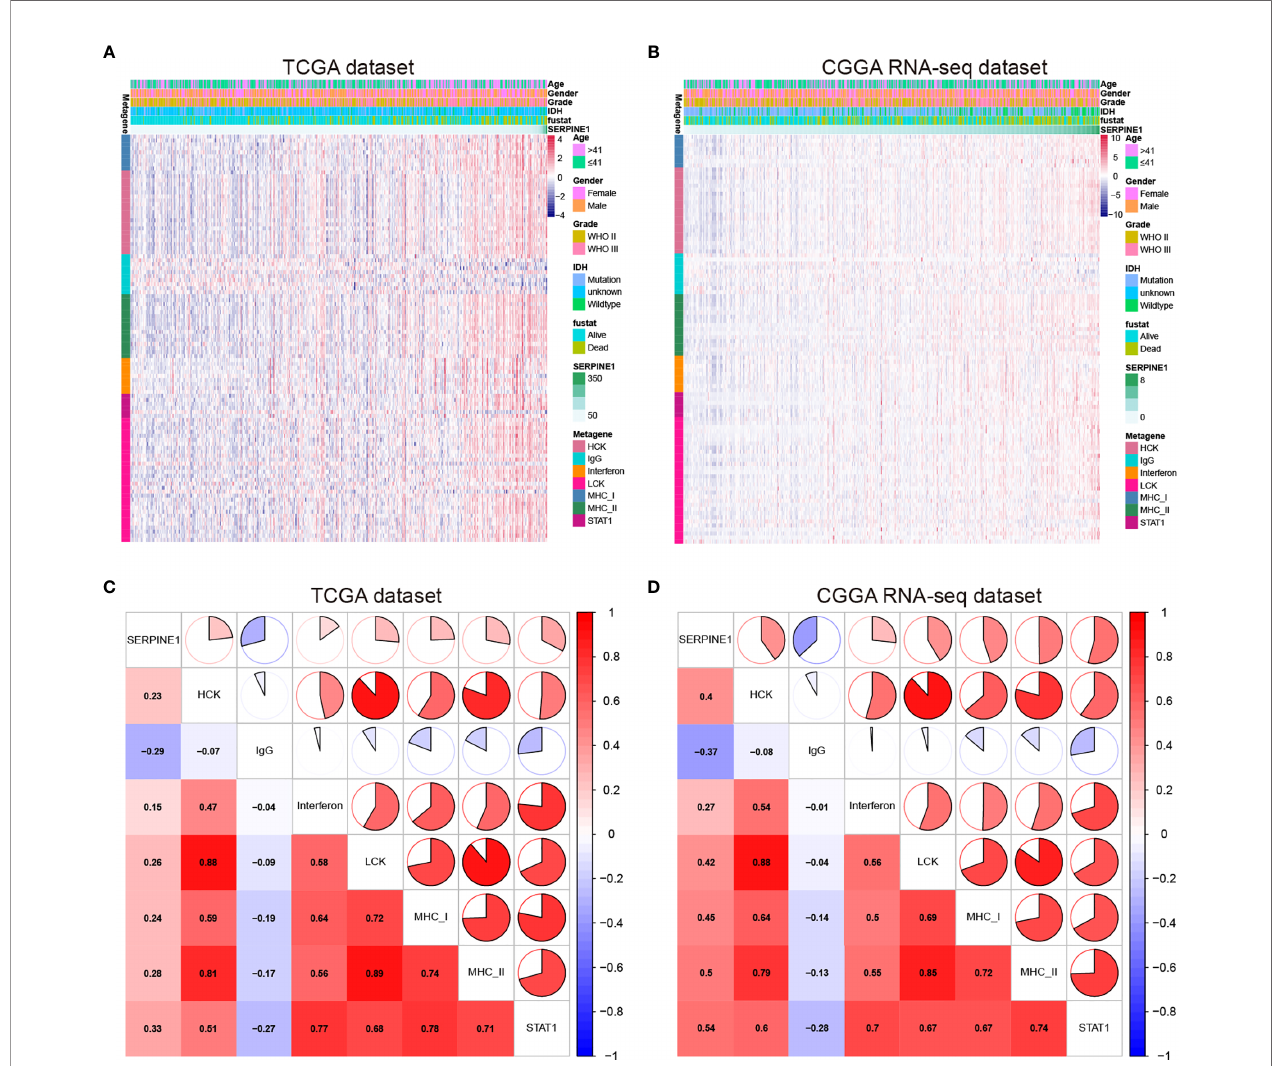
FIGURE 8 | SERPINE1-related in fl ammatory responses in LGG. (A, C) Heatmaps showing the relationship between SERPINE1 and seven metagenes in TCGA and CGGA datasets. (B, D) Correlogram showing the correlation between SERPINE1 and seven metagenes in TCGA and CGGA